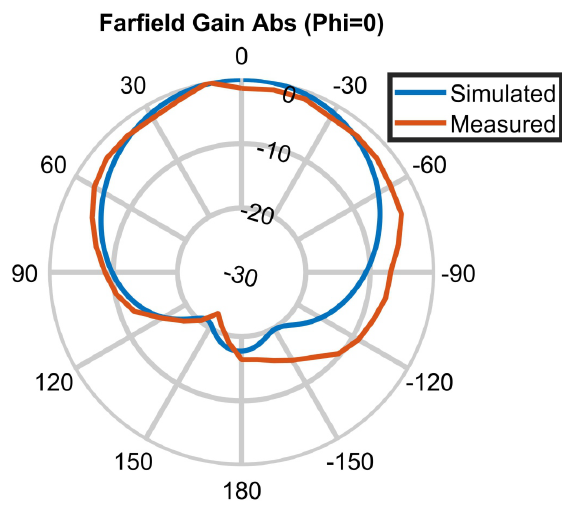
FIGURE 20. Simulated and measured normalized radiation patterns of the HGWMPA at 5.8 GHz (Phi=0 deg.